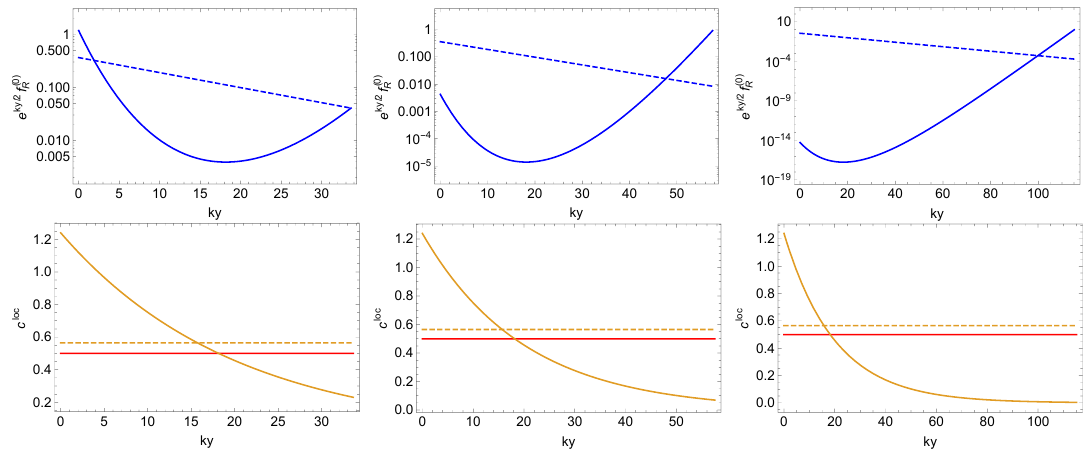
Figure 5 . From left to right, the IR brane is being pushed away from the UV brane with the hierarchies (cid:27) IR = 2 : 5 10 (cid:0) 15 ; 10 (cid:0) 25 and 10 (cid:0) 50 respectively. Upper panel: the normalized wave- (cid:2) function of the right-handed charm along the extra dimension. The solid curve is the wavefunction for the position-dependent bulk mass in eq. (7.3), whereas the dashed curve is for the usual case with constant bulk mass. Lower panel: the bulk-mass parameter c loc of the right-handed charm along the extra dimension. The solid curve is again for the position-dependent case in eq. (7.3) and the dashed curve for the usual constant case. The red curve marks the value c loc = 1 = 2 for which the wavefunction changes from decaying to growing towards the